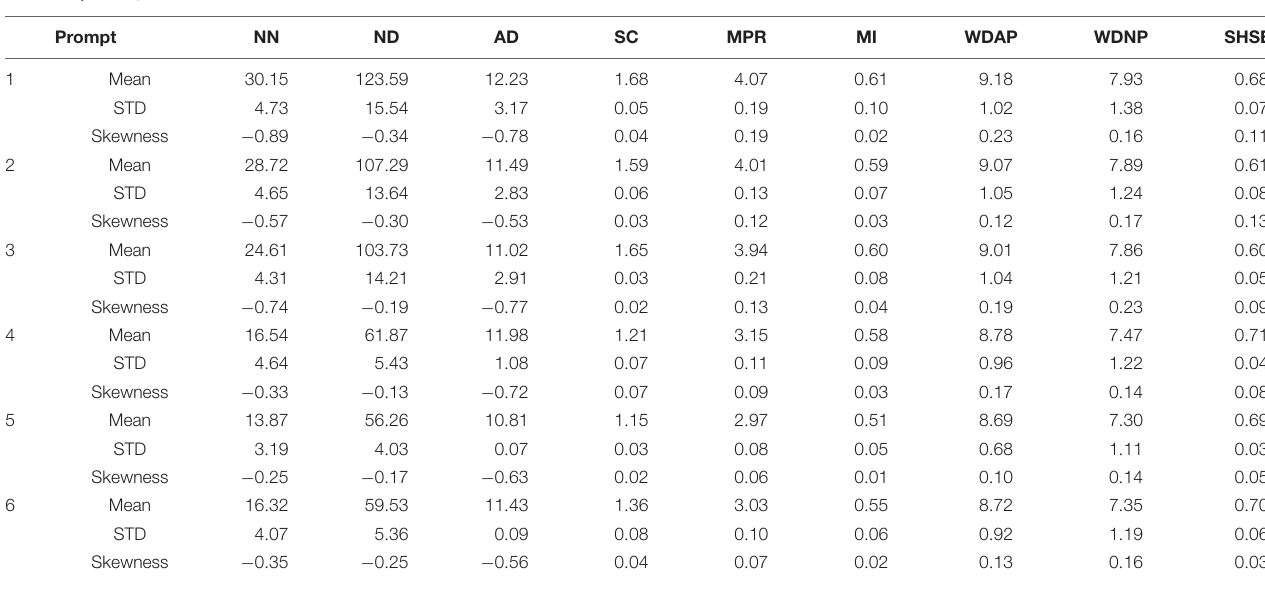
TABLE 5 | Descriptive statistics of the